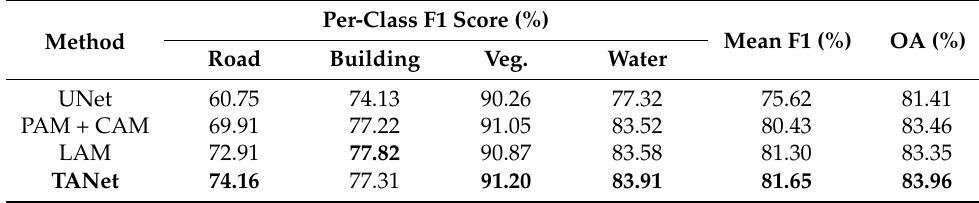
Table 3. F1 score, Mean F1, and OA index results of multi-object on CZ-WZ dataset.